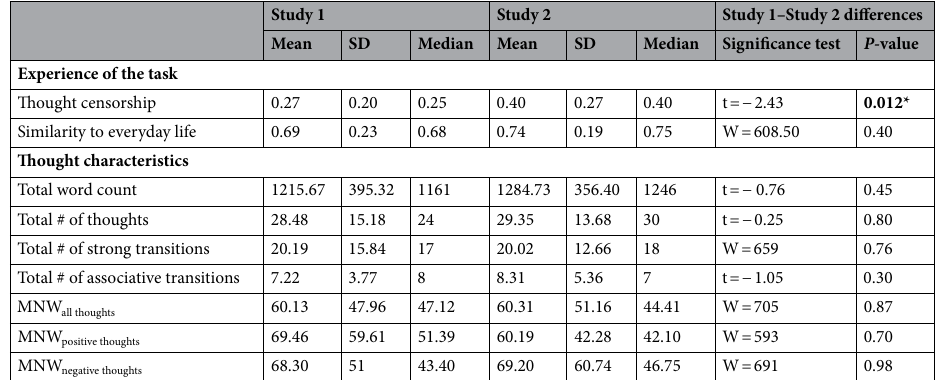
Table 1. Ecological validity and thought characteristics in Study 1 and 2. Statistical differences between Study 1 and 2 were evaluated with a two-tailed Welch t-test for normally distributed variables and a Wilcoxon rank-sum test for non-normally distributed variables. The scale of the thought censorship and similarity to everyday life questions is ‘0-Not at all’ to ‘1-Extremely’. MNW Mean Number of Words. Highlighted in bold are statistically significant group comparisons at p < .05. * P <